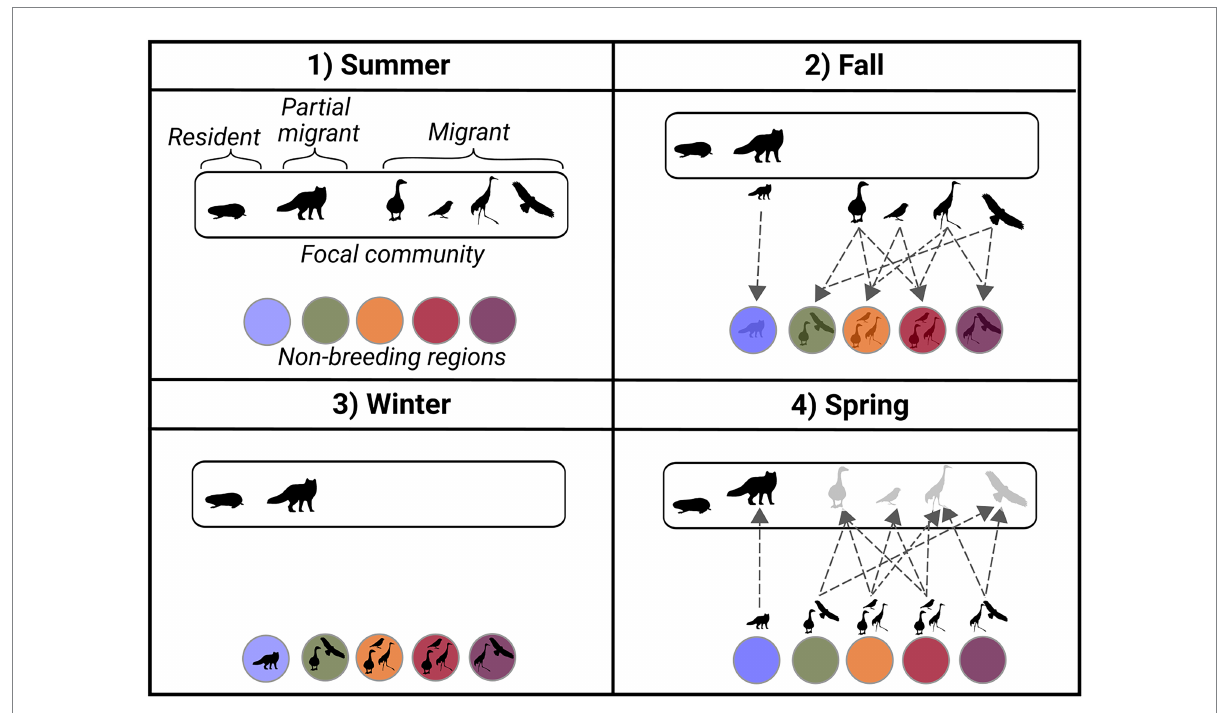
FIGURE 2 Schematic representation and definition of the seasonal nature of community migration networks through a fictive community representing a summer breeding ground used by multiple migratory species (white rectangle) and their migratory pathways (dotted lines) to non-breeding regions (colored circles). (1) Summer : populations of diverse migratory, partially migratory and resident species (black icons) co-exist at the same location, which defines the focal community (white rectangle) (2) Fall : the migratory and a part of the partially migratory populations leave the focal community through the migratory pathways (dotted lines) to reach non-breeding regions (colored circles) (3) Winter : the migratory and a part of partially migratory populations are distributed across diverse non-breeding regions, and the resident and a part of partially migratory populations stayed at the focal community location (4) Spring : the migratory and a part of the partially migratory populations from the focal community leave the non-breeding regions to reach the focal community location through the migratory